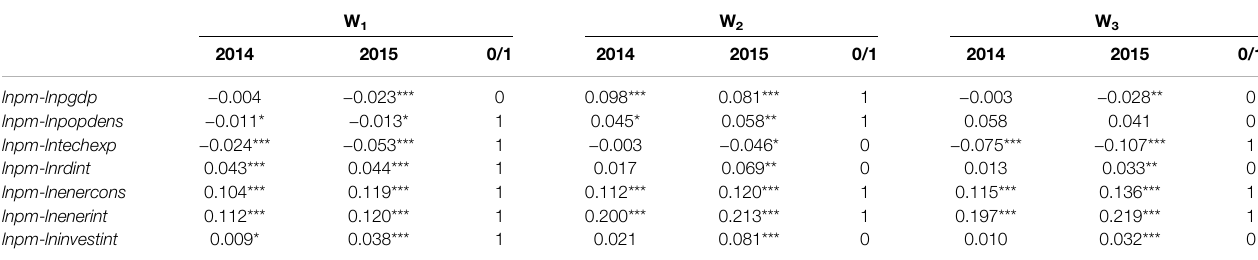
TABLE 4 | Results of Bivariate Moran ’ s I.